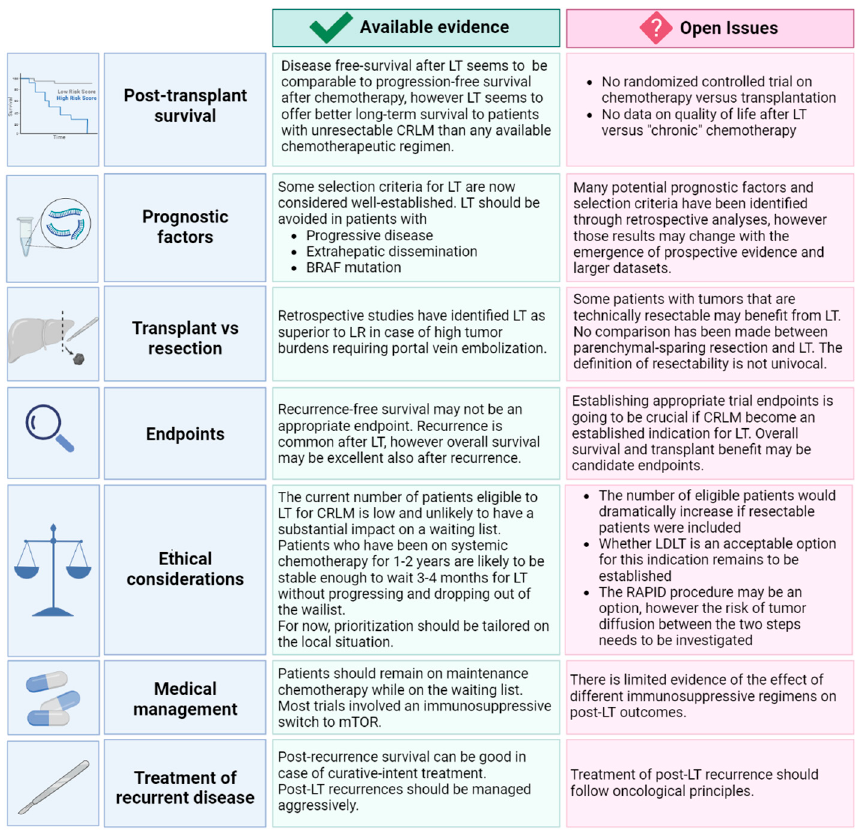
Figure 1. Overview of the available evidence and open issues in liver transplantation for colorectal liver metastases